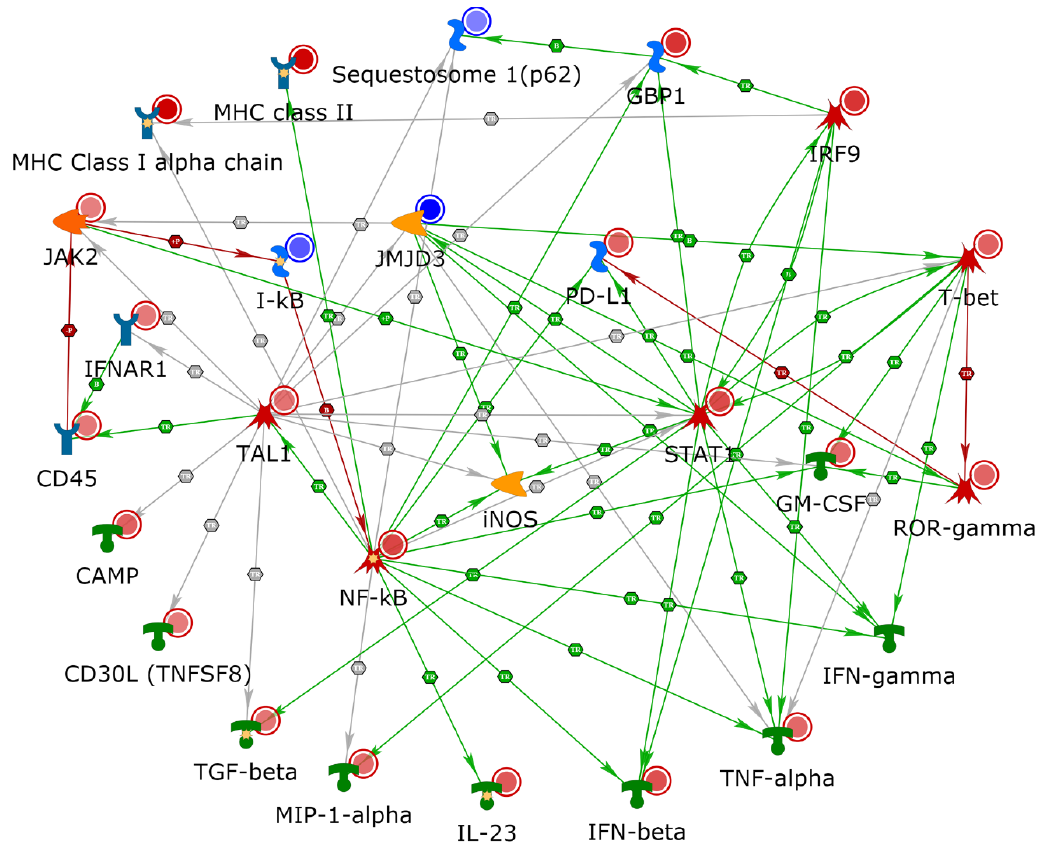
Figure 5. Expansion of direct interactions among cumulative analysis. The cumulative network was derived from direct interaction between members with ≥3 connections of both datasets along with major cytokines. To represent the antigen presentation machinery, MHC class I and class II nodes were added, as was also seen in our data. Given these interactions, interferon (IFN)-γ and iNOS were added as network objects, and both of these objects have direct interactions with nodes found to be regulated in our experimental dataset.